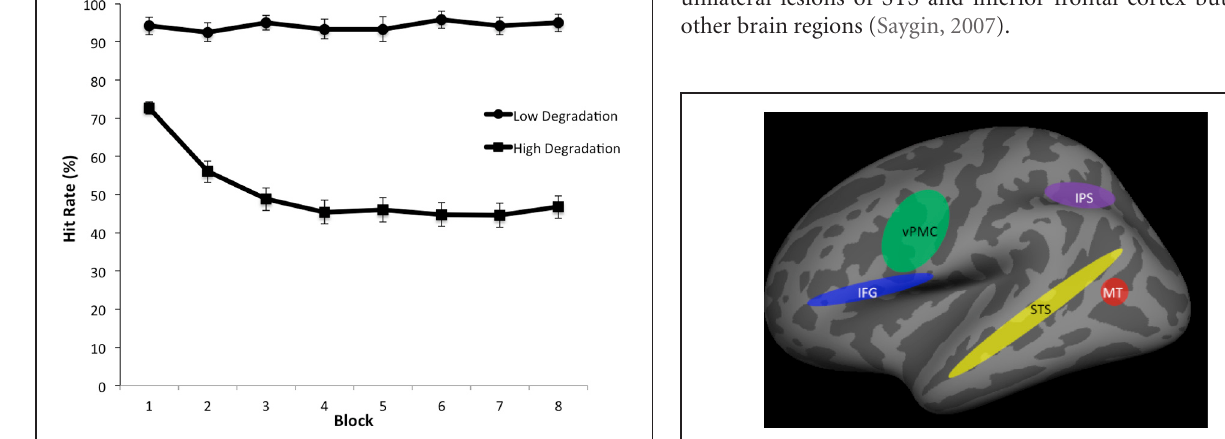
FIGURE 3 | Detection rate of threatening actions as a function of time on task (blocks) under low and high visual degradation conditions. From Parasuraman et al. (2009).